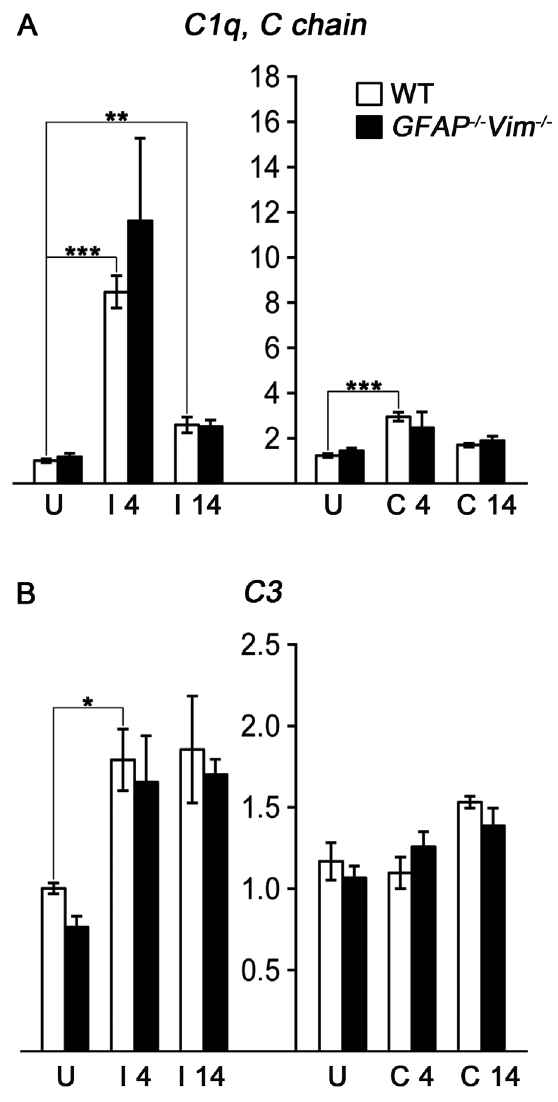
Figure 4. Complement components C1q and C3 upregulation following ECL. (A) Complement component C1q (here represented by C1q, C chain ) mRNA is upregulated in the hippocampal tissue at the injured side (I) at both 4 and 14 days after injury and (B) C3 mRNA is upregulated at 4 days after injury. C1q is also upregulated at the contralesional side (C) at day 4. U, uninjured control; * p , 0.05; ** p , 0.01; *** p , 0.001.